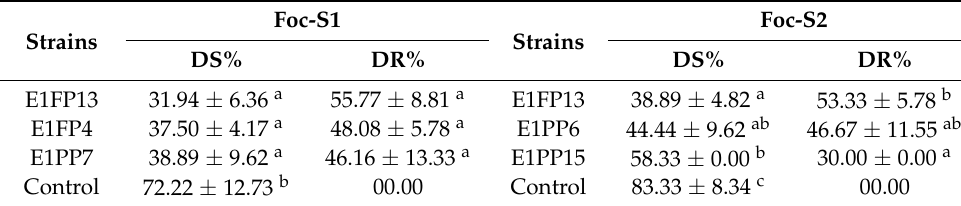
Table 4. In vivo effect of selected Pseudomonas strains on Foc isolates.